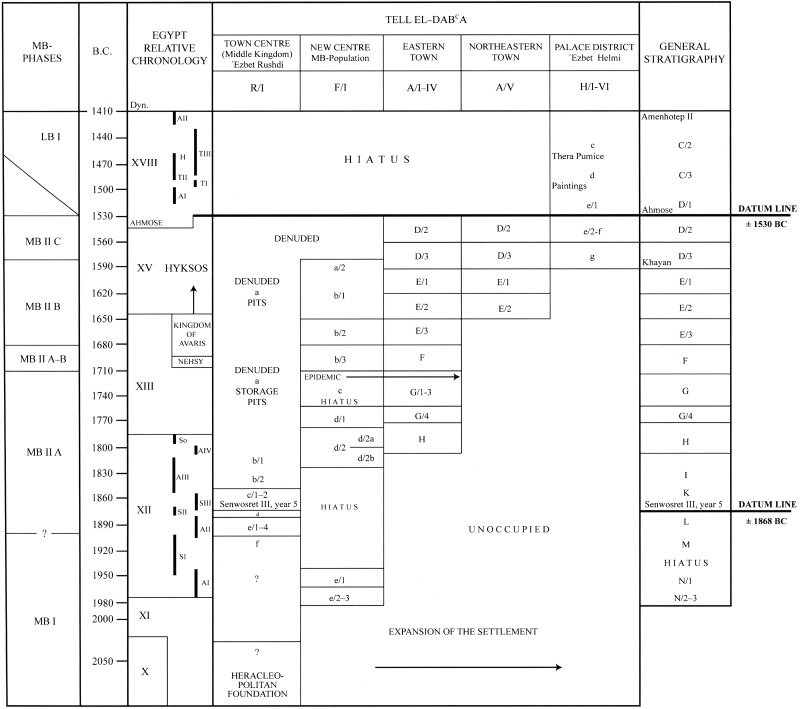
The site stratigraphy system.After [15].